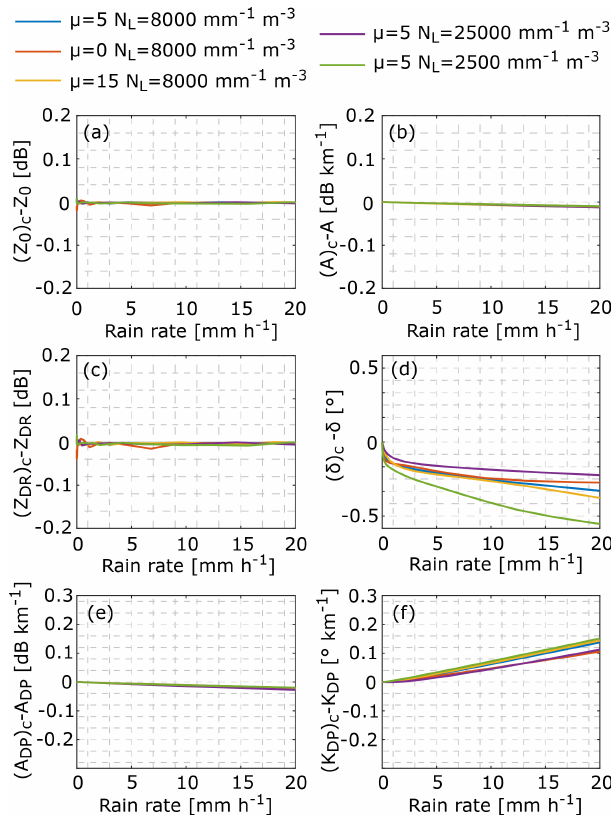
Figure 7. Differences between reflectivity (a) , specific attenuation (b) , differential reflectivity (c) , backscattering differential phase (d) , differential attenuation (e) , and specific differential phase (f) calcu- lated with a 10 and 0 ◦ standard deviation of the canting angle dis- tribution. Variables calculated with 10 ◦ are indicated by the index “c”. The differences are shown for different DSDs and are indicated by line colors.